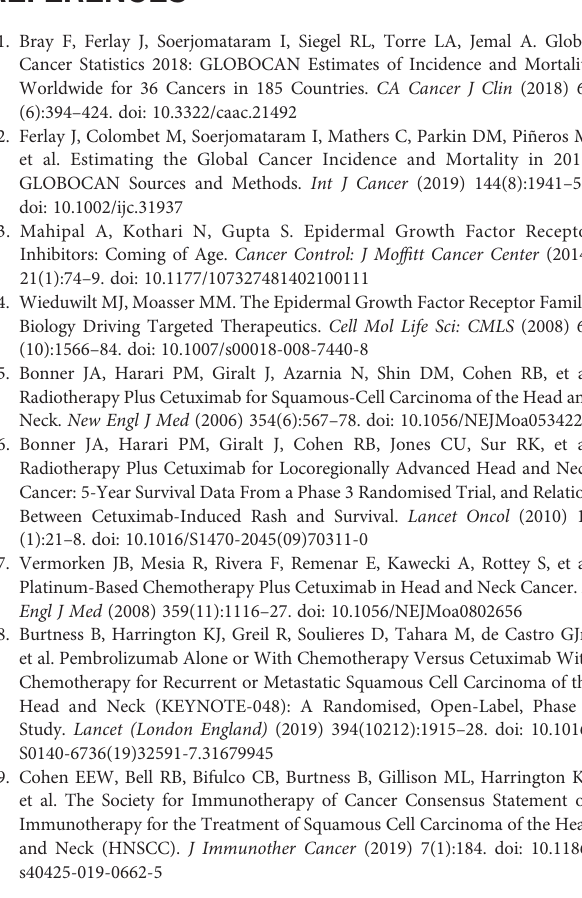
Supplementary Figure 1 | mRNA expression level of Akt1/2/3 in HNSCC patients, available from TCGA. The graph shows the log transformed mRNA